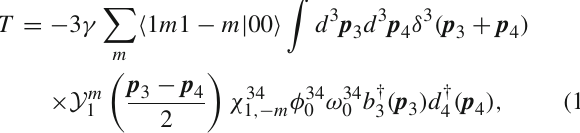
The transition operator T of the decay A → BC in the 3 P 0 model can be